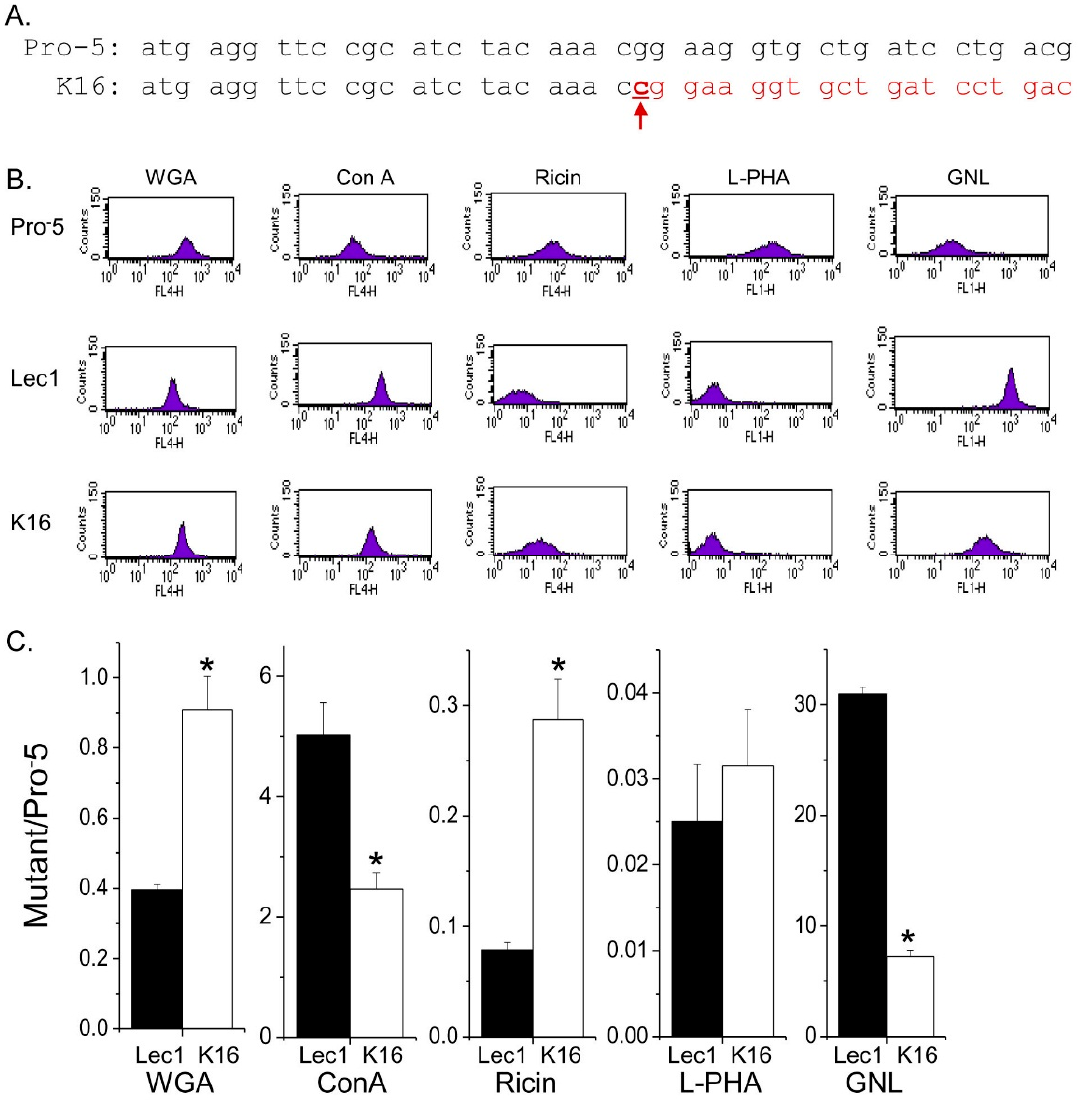
Figure 1. Characterization of an N -glycosylation mutant Pro − 5 Chinese Hamster Ovary (CHO) cell line generated by employment of the CRISPR/Cas9 method. The coding sequence (CDS) of the Mgat2 gene from 1 to 42 is shown for the parental cell line, Pro − 5, and the isolated clonal cell line, K16 ( A ); K16 has the Mgat2 gene silenced due to insertion of c after the 22nd nucleotide, as denoted by the red arrow. The red font indicates the changes in the codon as a result of the insertion; Representative flow cytometry histograms of five fluorescently labelled lectins binding to each of the CHO cell lines ( B ); Ratios of mean fluorescence values of the N -glycosylation mutant cell lines to the parental cell line were determined and compared from four separate experiments ( n = 4) ( C ). Mean ratio values close to 1 indicate that the binding of the N -glycosylation mutants were similar to Pro − 5. (*, p < 0.02) denote that K16 was significantly different from Lec1.